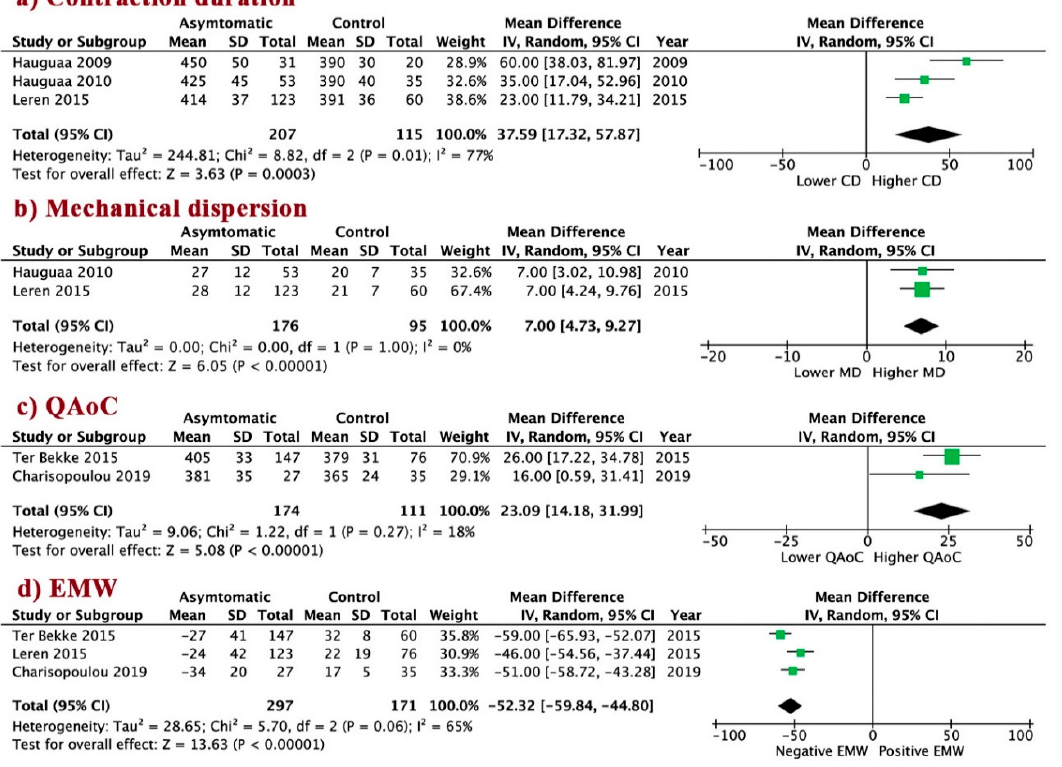
Figure 3. Mechanical abnormalities in asymptomatic patients vs. control. ( a ) Conctraction duration; ( b ) Mechanical dispersion; ( c ) QAoC; ( d ) EMW. LQTS: long QT syndrome; QAoC: QRS onset to peak systolic strain, EMW: electro-mechanical window; CD: contraction duration; MD: mechanical dispersion.